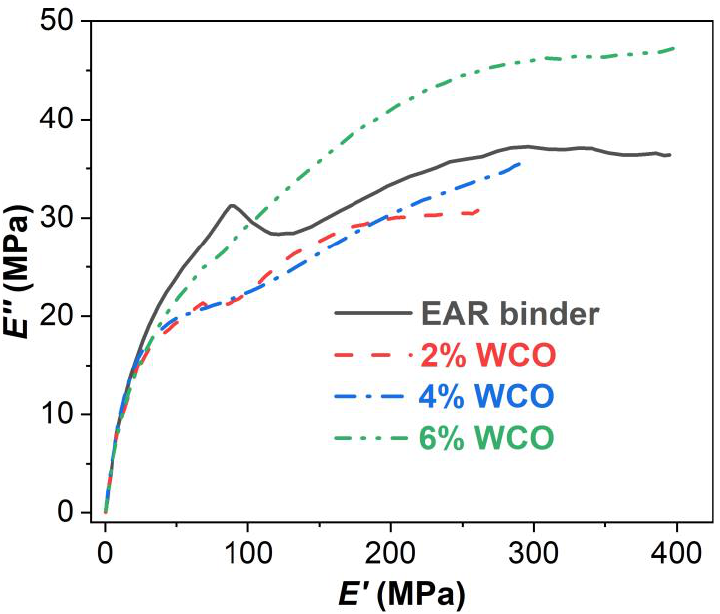
Figure 5. Cole-Cole plots of the unmodified and WCO-modified EAR